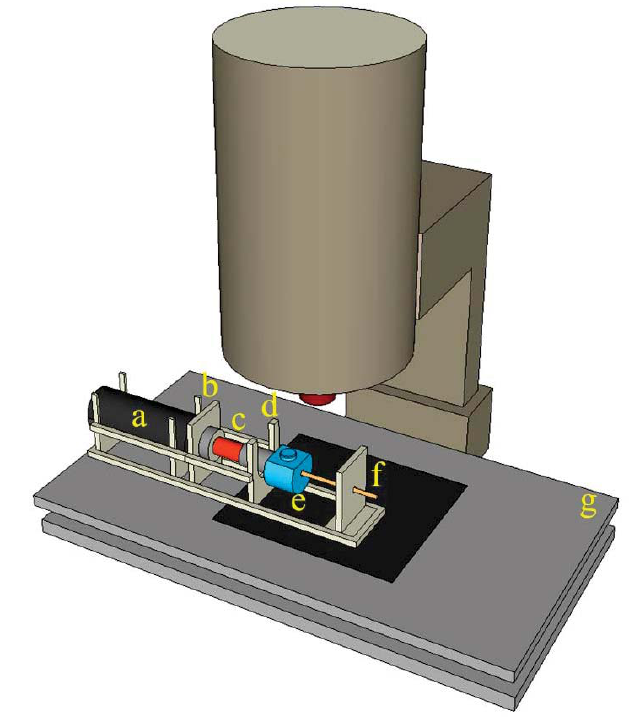
Figure 11. Schematic of the tool used for qualitative analysis of the optical transmission defects: ( a ) laser source; ( b ) collimator; ( c ) fiber cable; ( d ) fiber adapter; ( e ) fiber connecter; ( f ) processed fiber; and ( g )